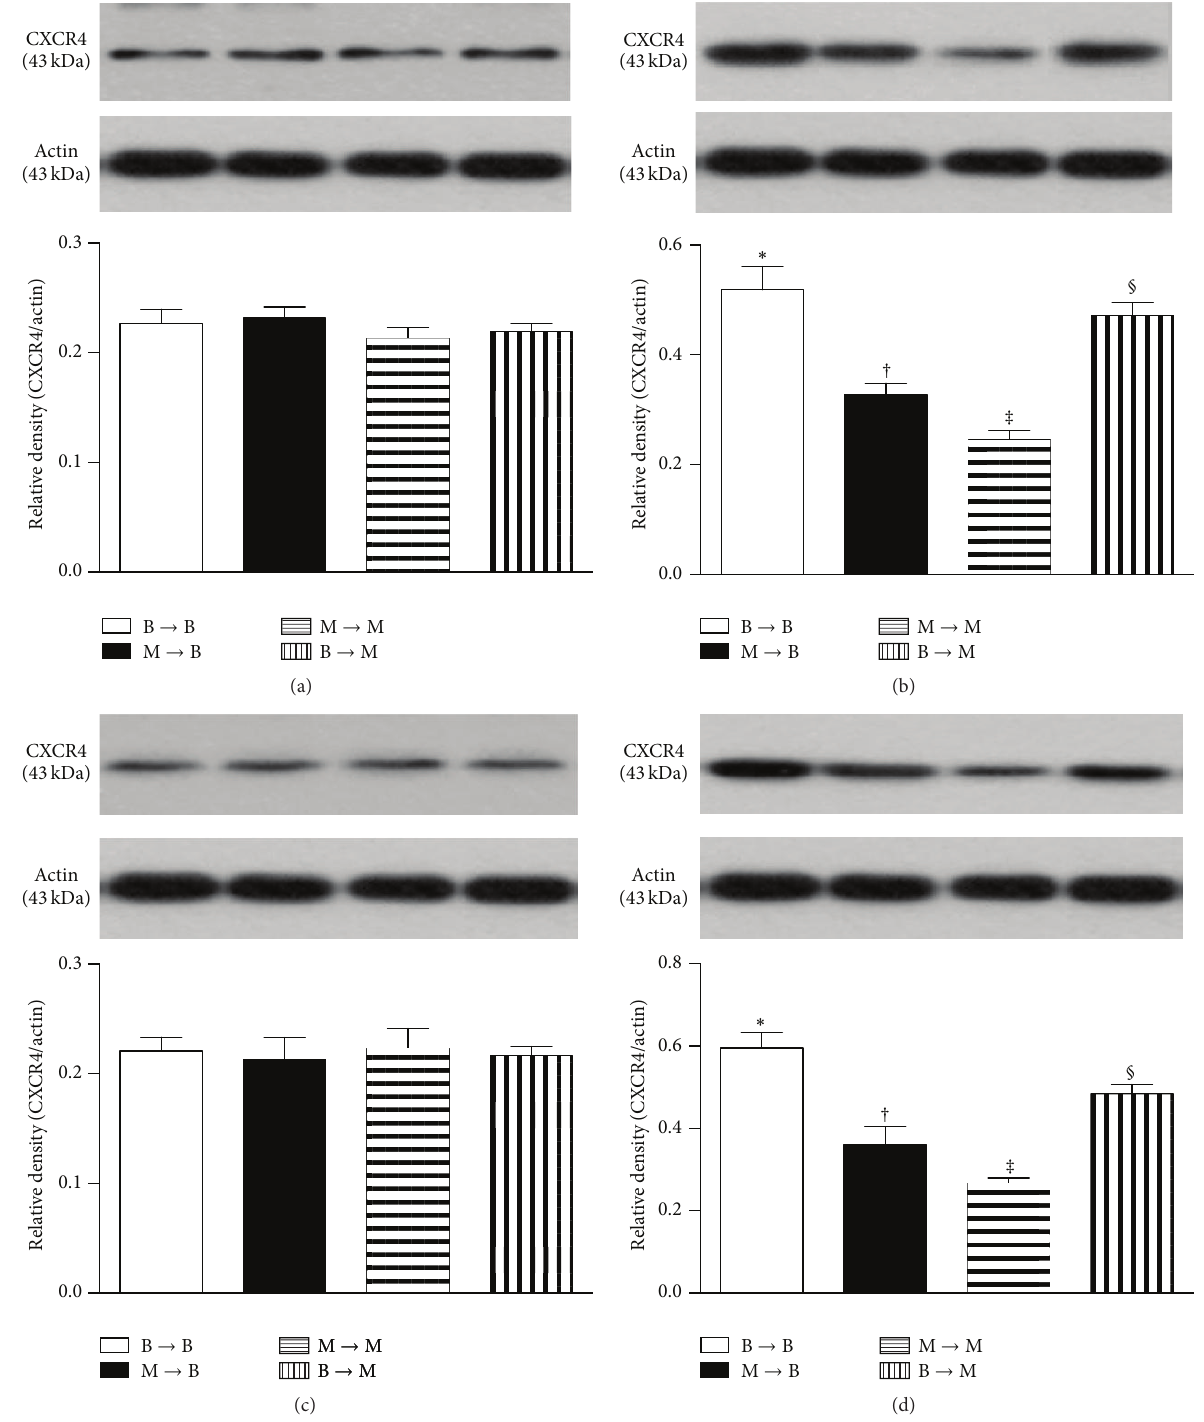
Figure 10: Protein expression of CXCR4 in ischemic quadriceps at day 14 after critical limb ischemia (CLI) induction. (a) At sham control (SC) treatment condition, CXCR4 did not differ among four groups, 𝑝 = 1.0 . (b) At CLI subgroup, groups with different symbols ( ∗ , † , ‡ , and §), 𝑝 < 0.05 . (c) At SC + tPA subgroup, CXCR4 did not differ among four groups, 𝑝 = 1.0 . (d) At CLI + tPA subgroup, groups with different symbols ( ∗ , † , ‡ , and §), 𝑝 < 0.05 . All statistical analyses were performed by one-way ANOVA followed by Bonferroni multiple comparison post hoc test. tPA = tissue plasminogen activator. 𝑛 = 6 for each